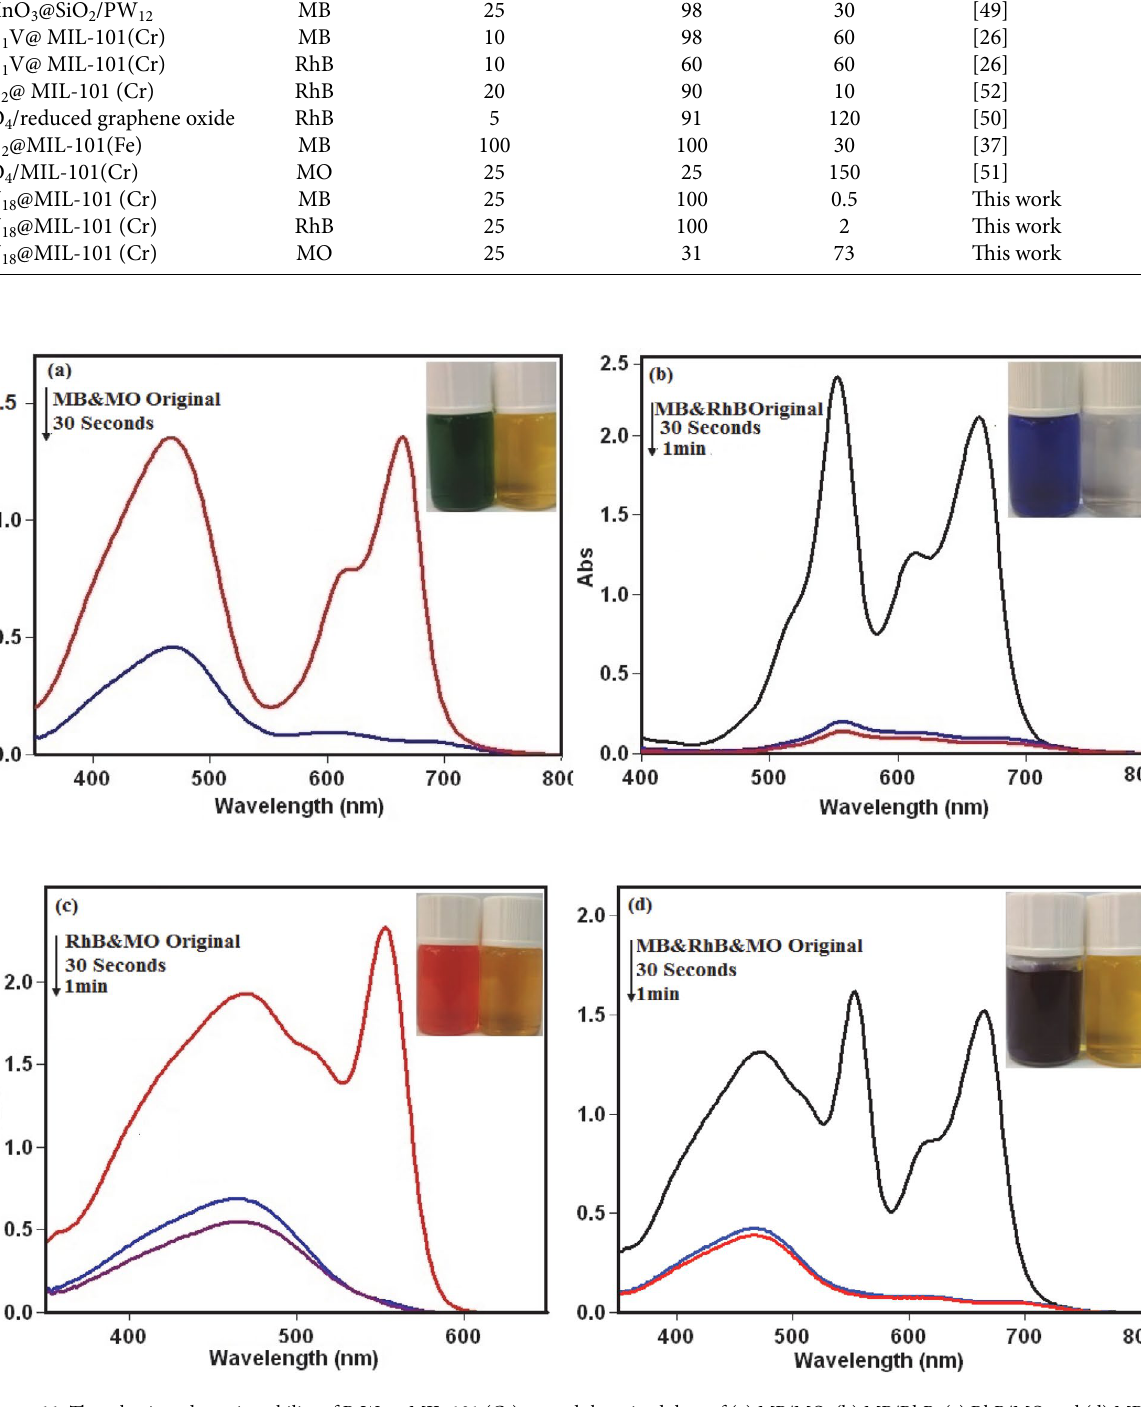
Figure 11. The selective adsorption ability of P 2 W 18 @MIL-101 (Cr) toward the mixed dyes of (a) MB/MO, (b) MB/RhB, (c) RhB/MO and (d) MB/ MO/RhB. Conditions: C 0 (MB) = C 0 (RhB) = C 0 (MO) = 25 mg/L; adsorbent dose = 25 mg in 30 mL mixed dye solution at 25